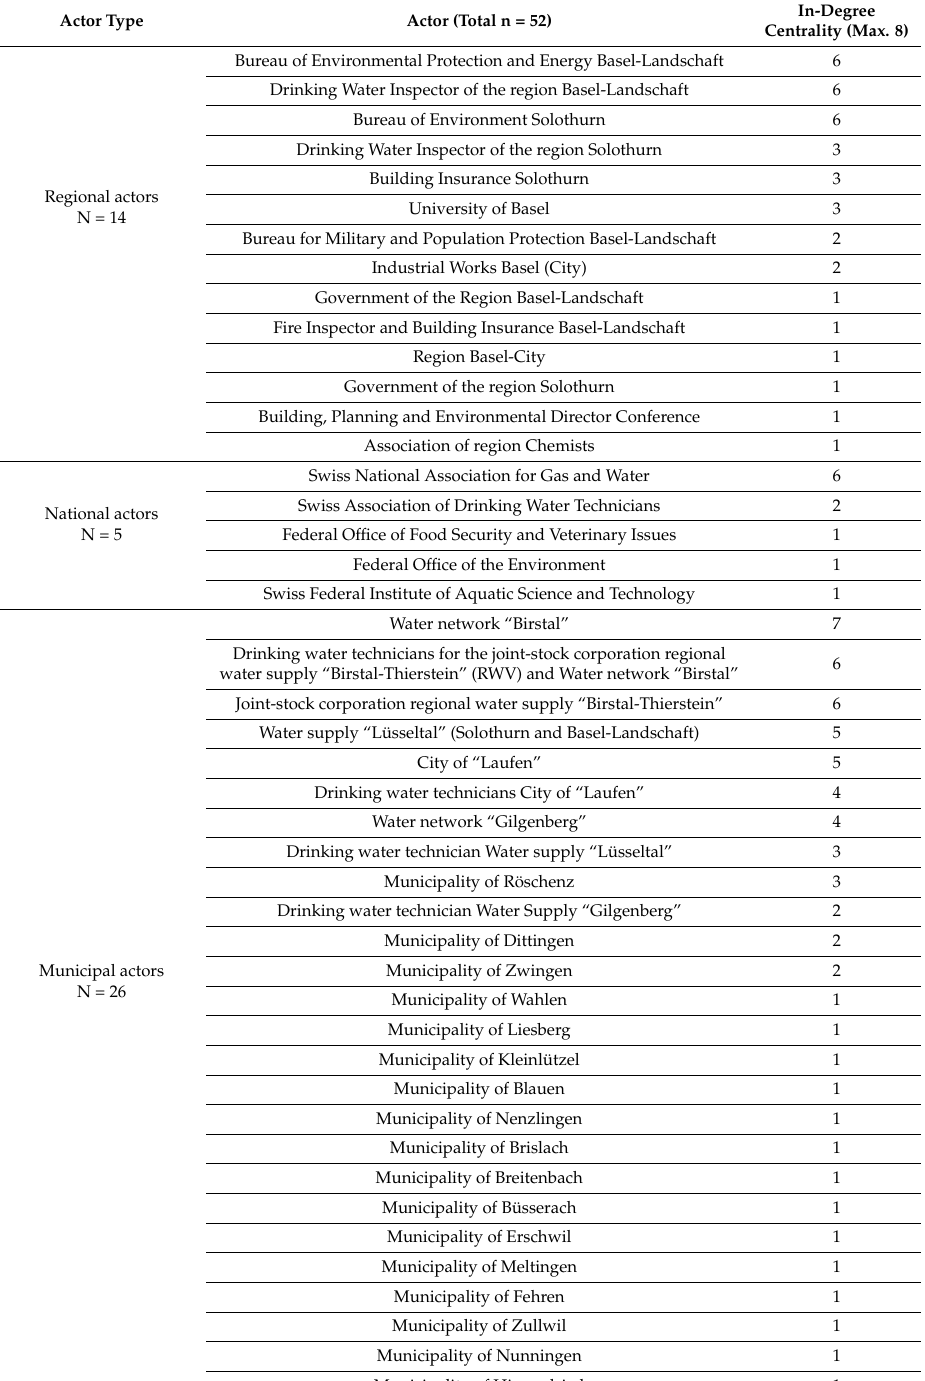
Table A1. In-degree centralities in Case